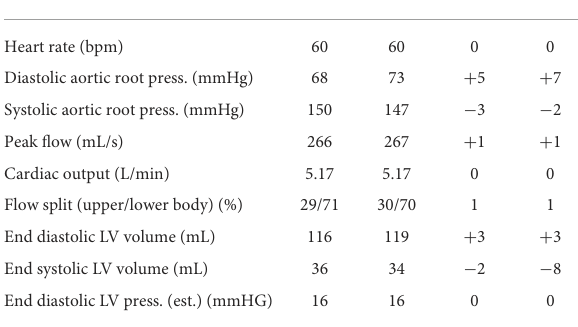
TABLE 1 Patient data compared with the patient-specific closed-loop computational model (abs, absolute; press.,